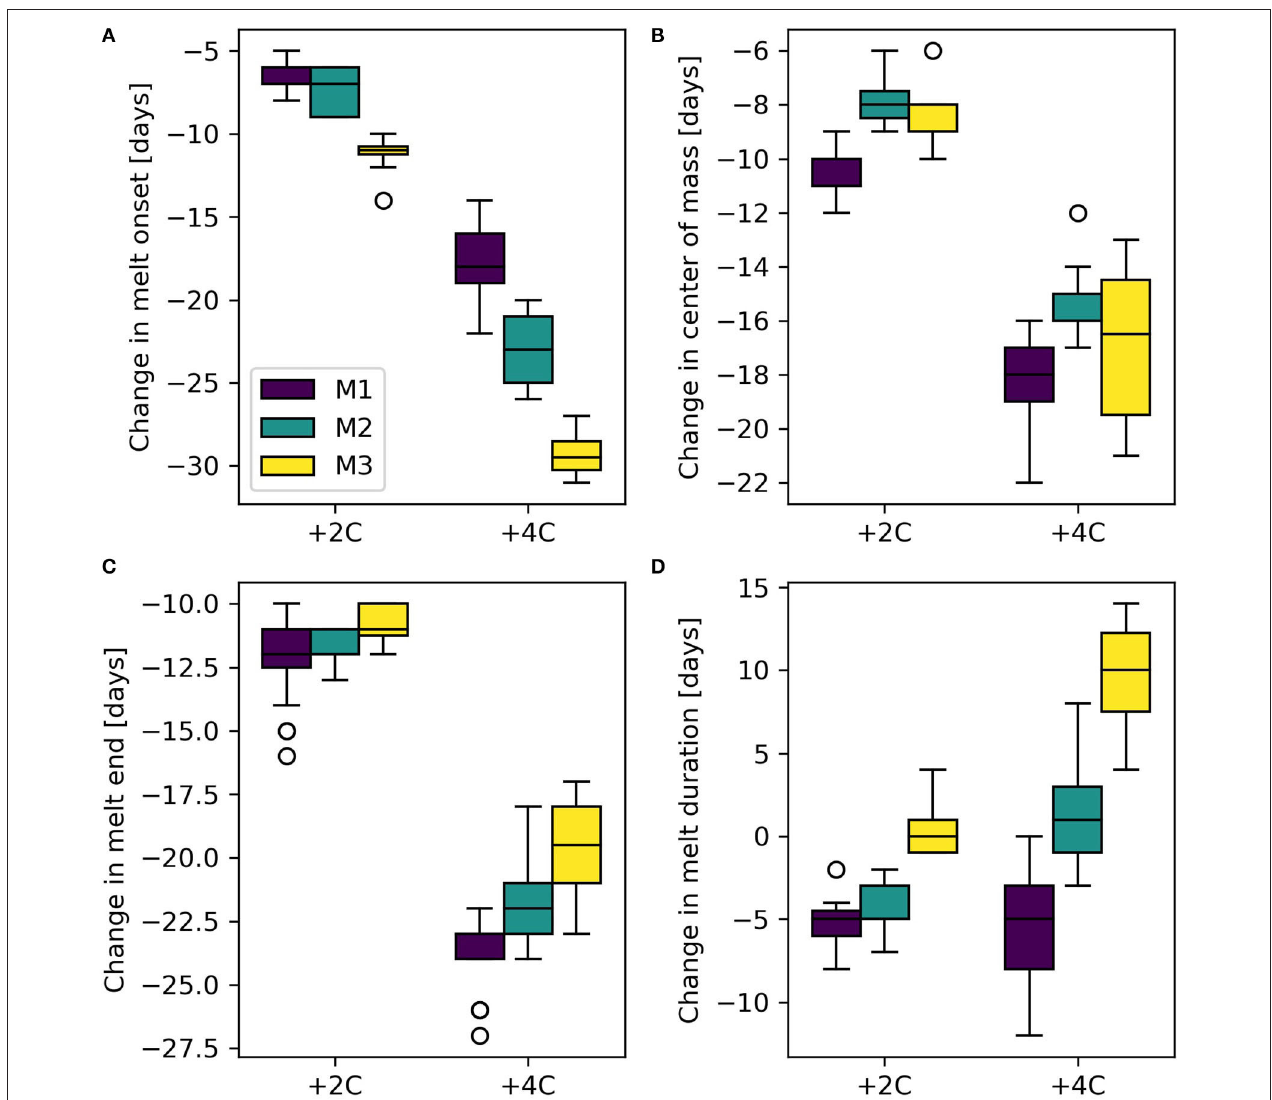
FIGURE 10 | Boxplots of changes in melt season metrics for 50 basins sorted by hypsometry type: (A) melt onset, (B) center of melt, (C) melt end, and (D) melt season duration, for + 2 and + 4 ◦ C temperature